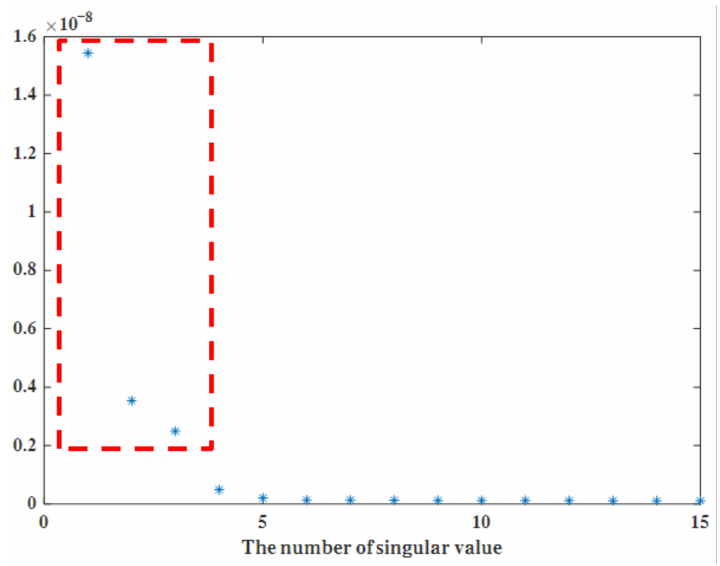
Figure 8. The results of the number of singular values when oil − film dielectric is not damaged.